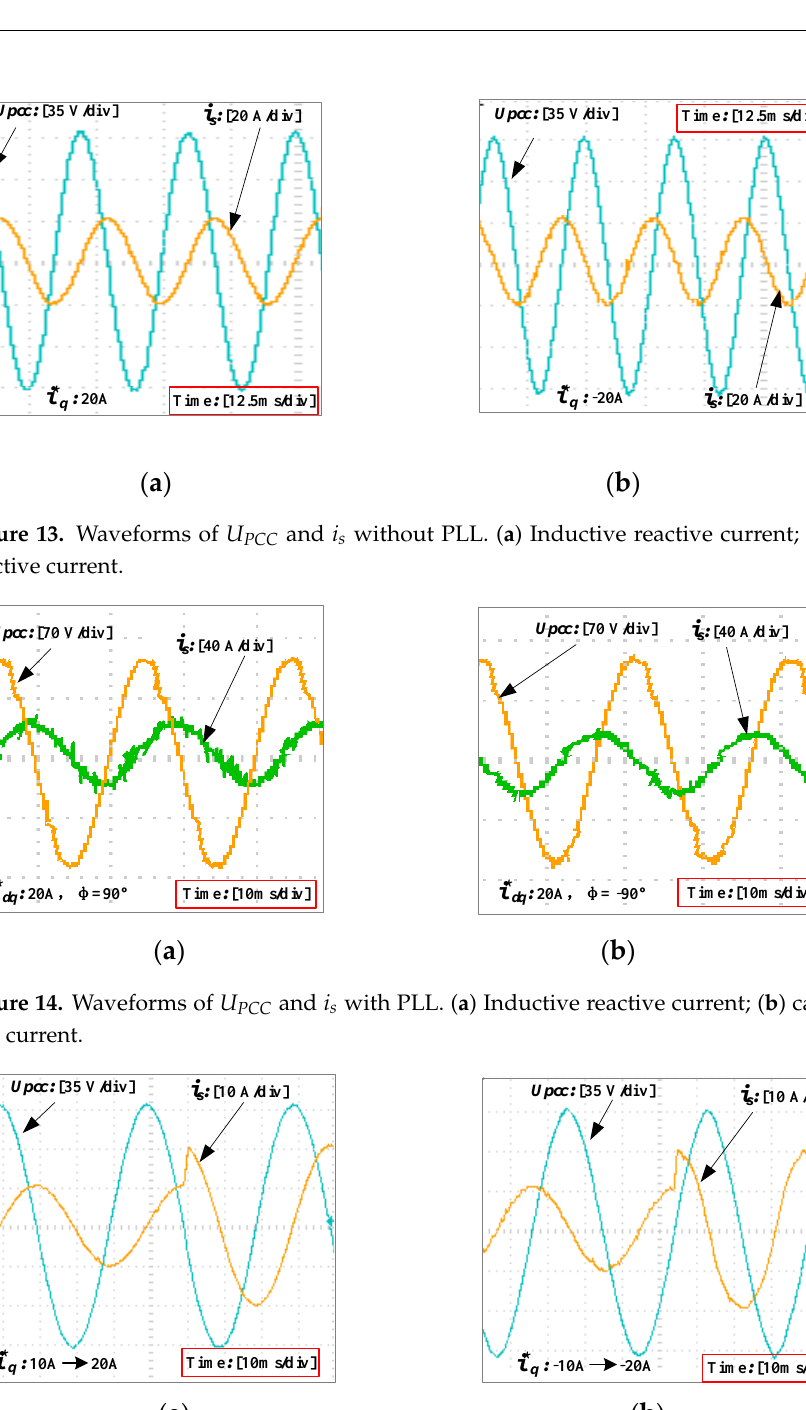
Figure 15. Waveforms of U PCC and i s without PLL when Z g = 1.8 mH. ( a ) i ∗ q changes from 10 A to 20 A; ( b ) i ∗ q changes from − 10 A to − 20 A.